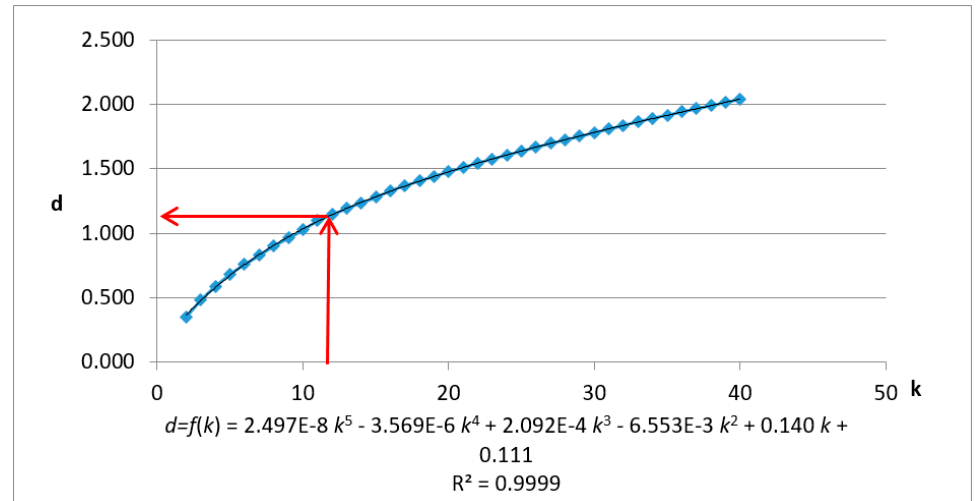
Figure 15. Chart and fitting curve of the mean max distance of the k nearest neighbor of mobile laser